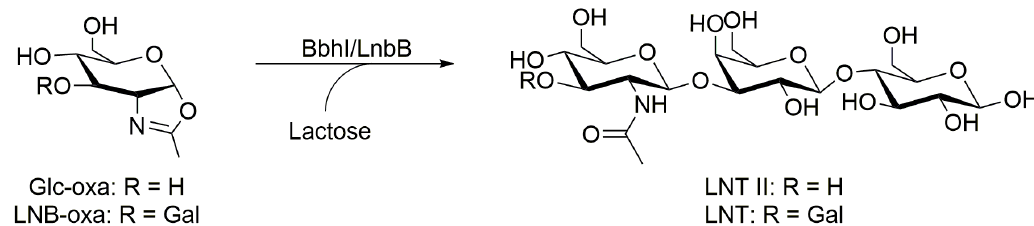
Figure 6. BbhI and LnbB catalyzed trans-glycosylation reaction for synthesis of LNT II and LNT, respectively, using Glc-oxa as donor substrate.